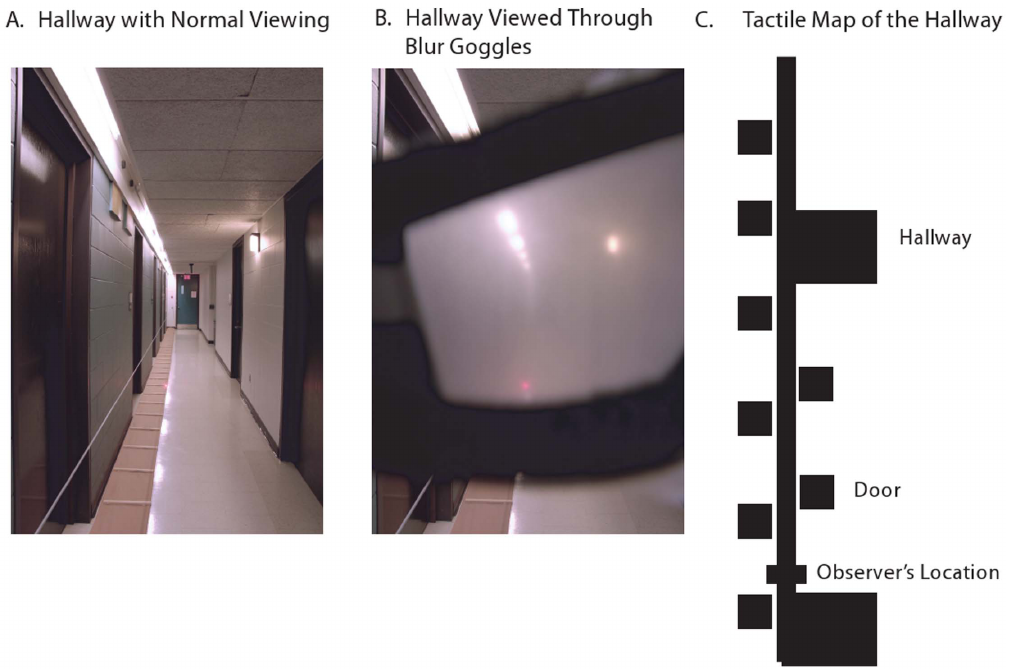
Figure 2. Test hallway and materials. Images of the hallway with (A) normal viewing, (B) viewed through the blur goggles, and (C) as represented by the tactile map.